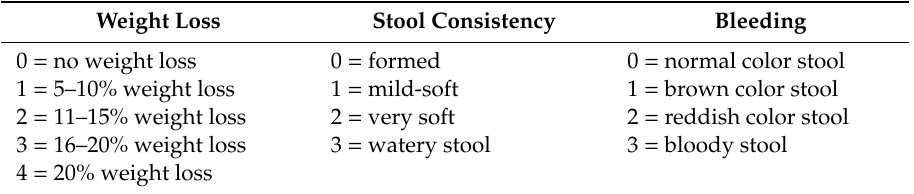
Table 1. Disease activity index score